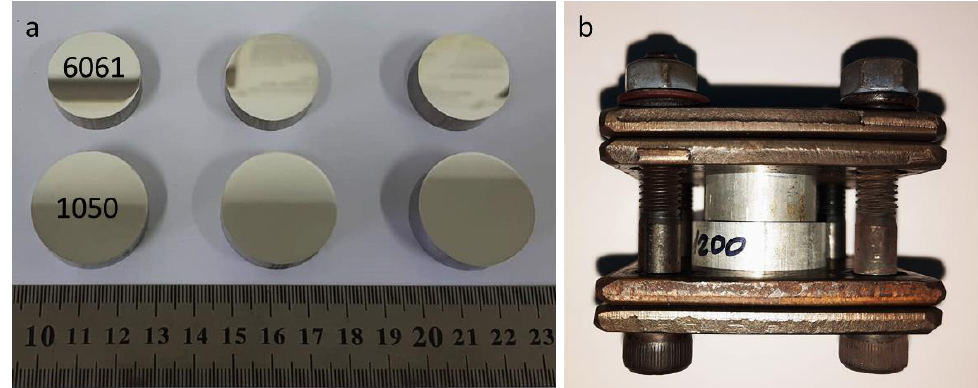
Figure 2. ( a ) Cylindrical AA1050 and AA6061 specimens after polishing; ( b ) Bonding couple before DB experiments.